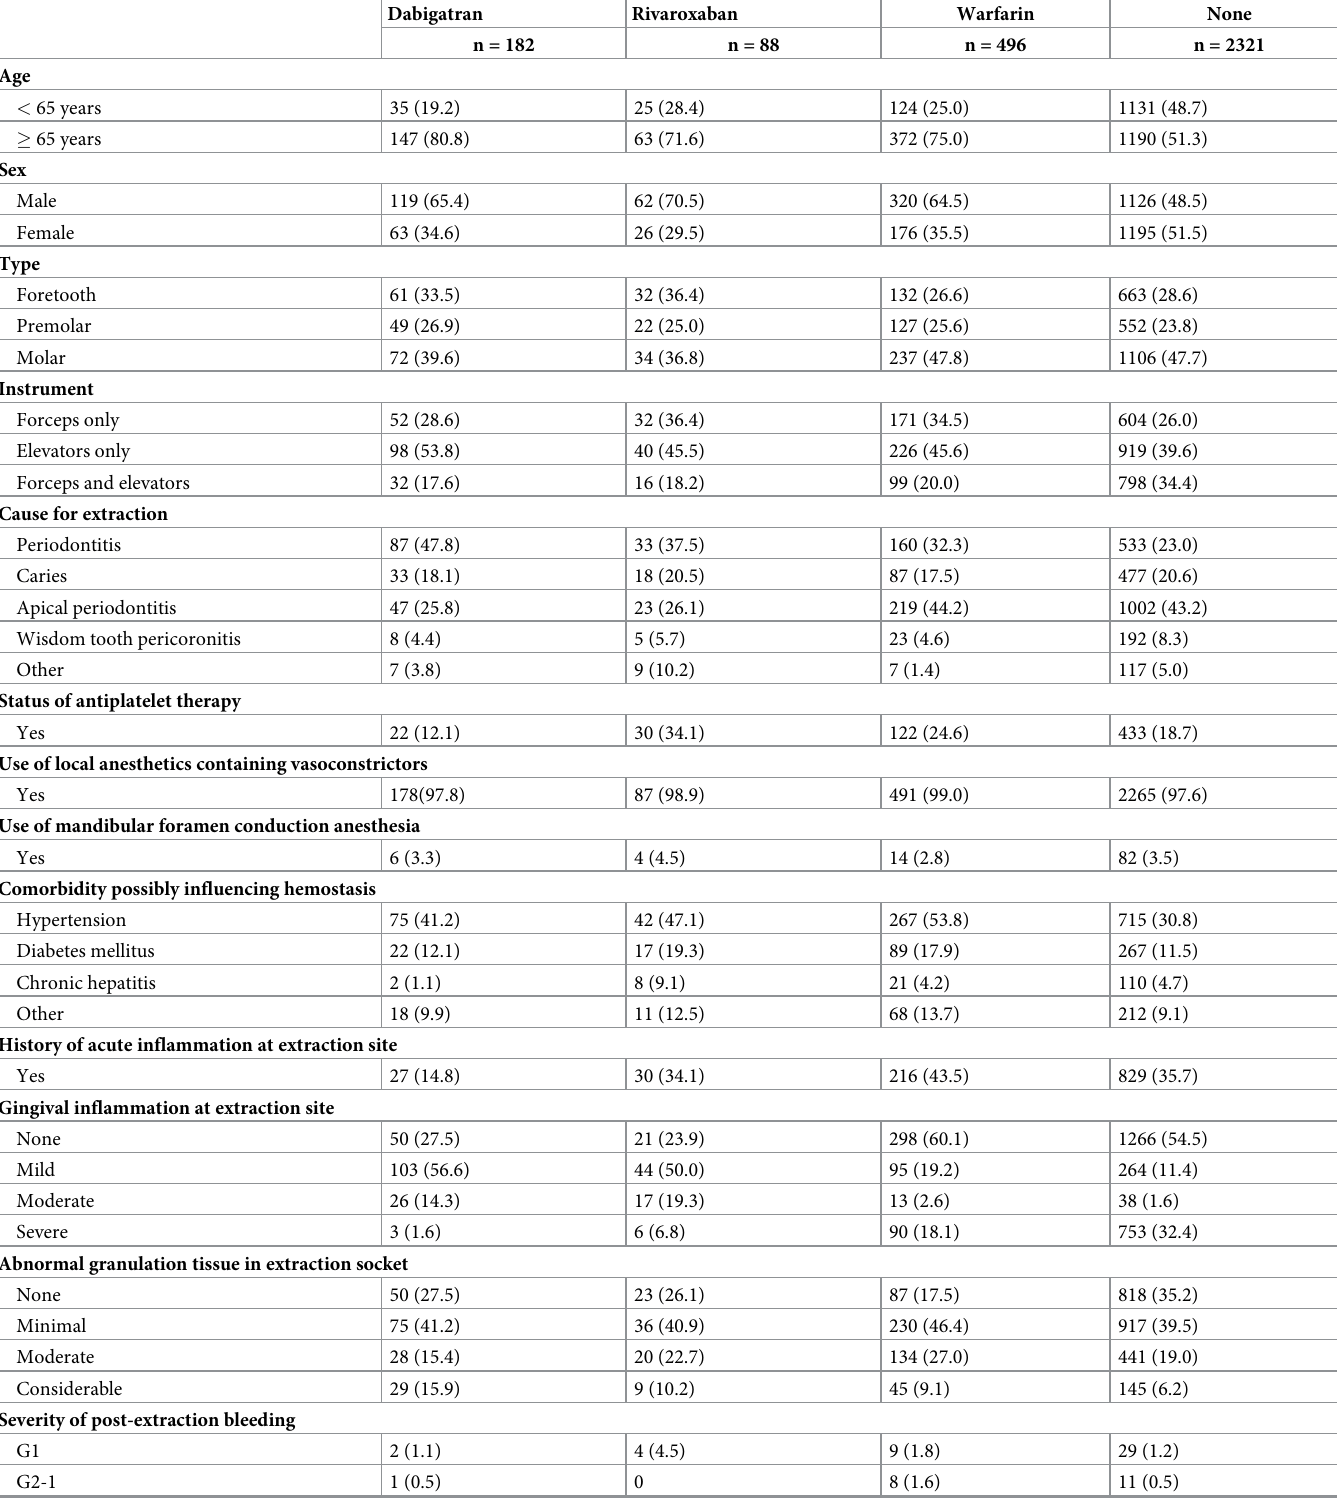
Table 1. Patient